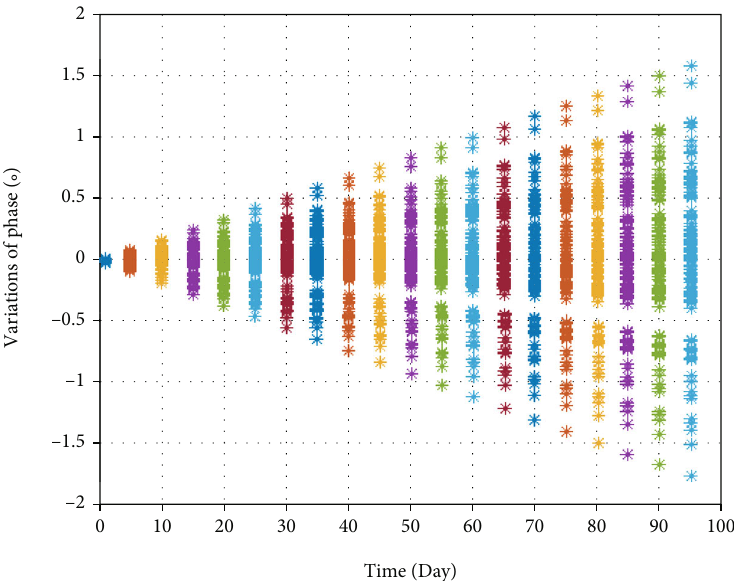
Figure 8: Variations of phase ( h = 550km , i = 53 ° ).